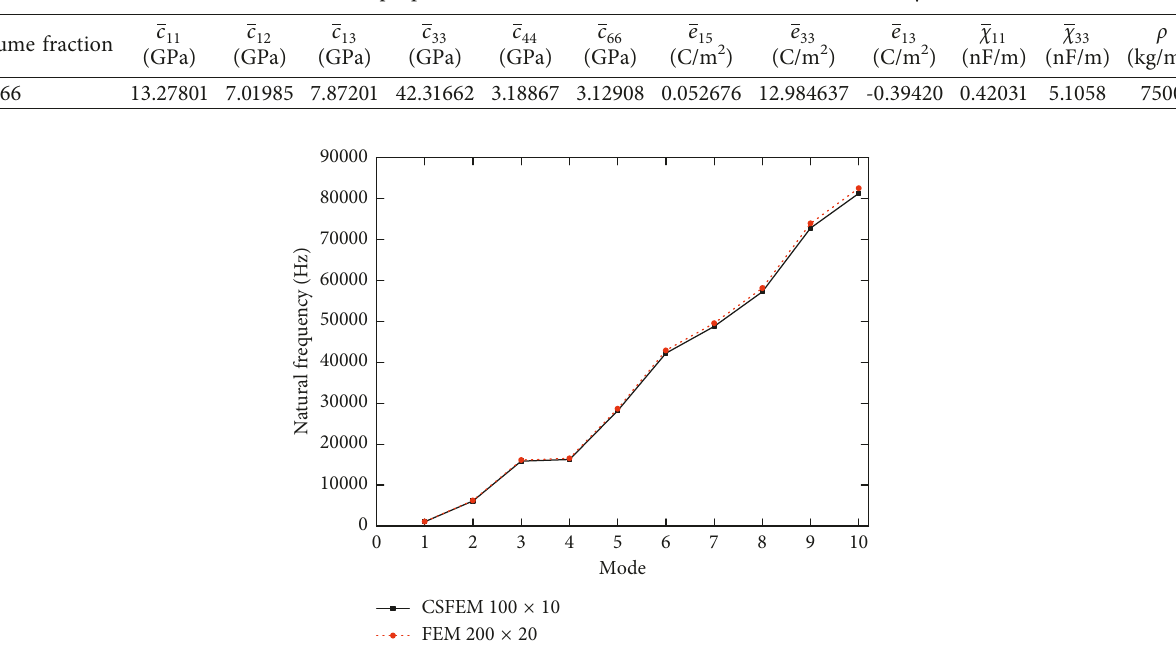
Figure 11: A cantilever PCMs beam. Table 3: The material properties of the cantilever PCMs beam were calculated by AHM.